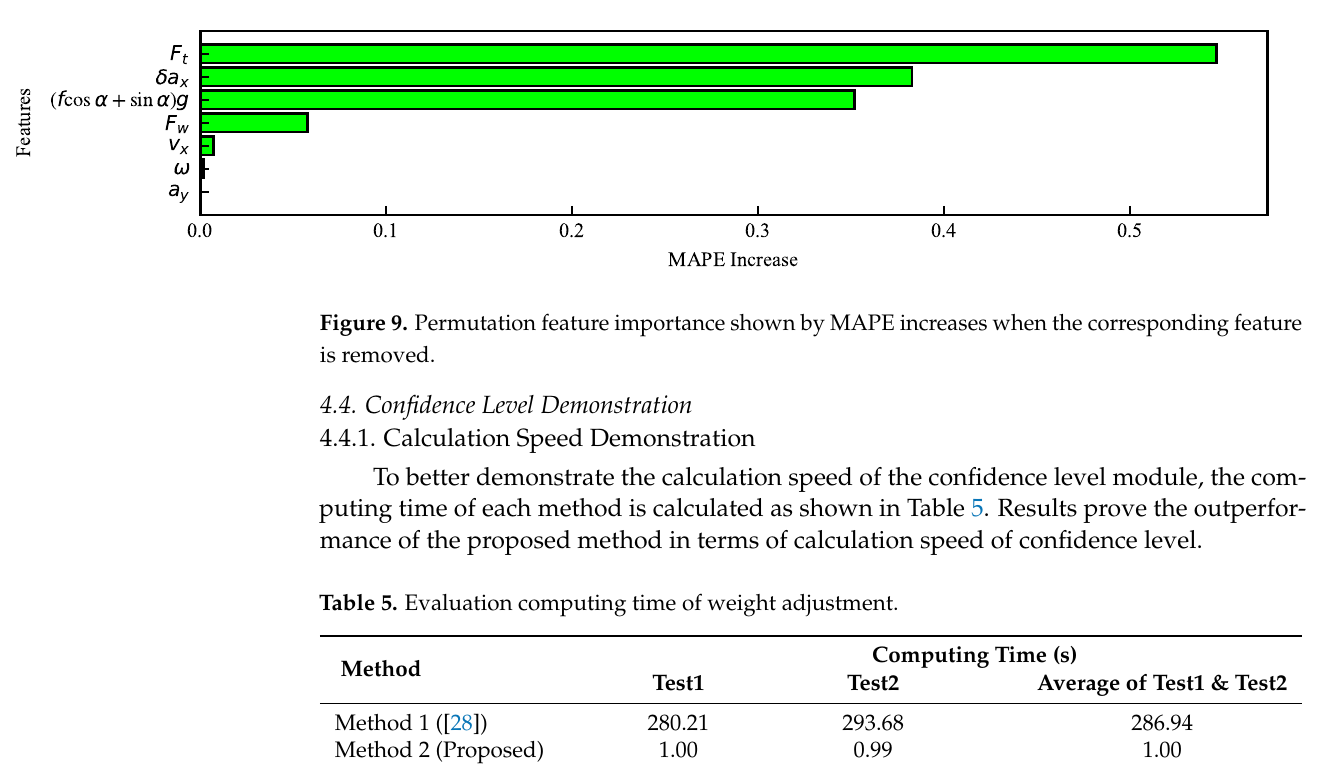
Table 6. Evaluation Metrics Method